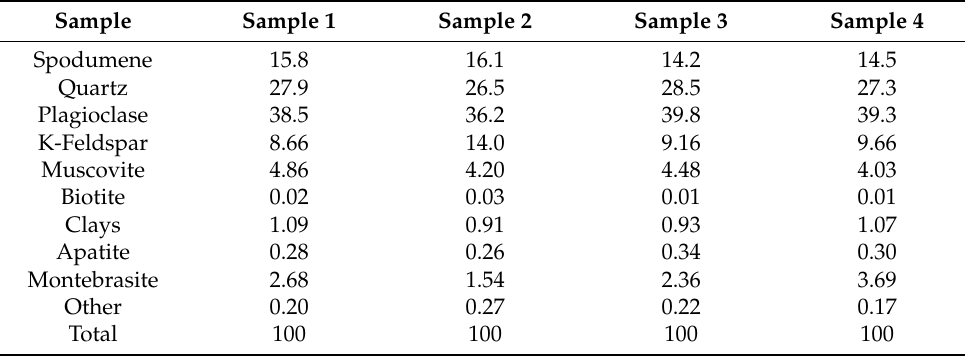
Table 2. Modal mineralogy (wt. %)—sample determined by